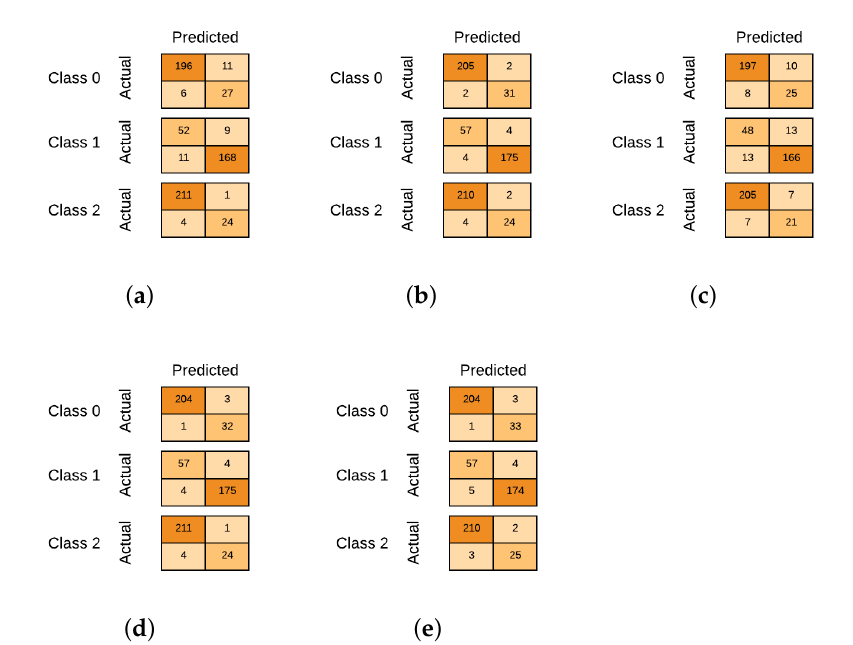
Figure 7. Confusion matrix comparison of the proposed scheme ( a ) DT, ( b ) RF, ( c ) ANN, ( d ) XGBoost classifier, and ( e ) ensemble learning: RanKer .